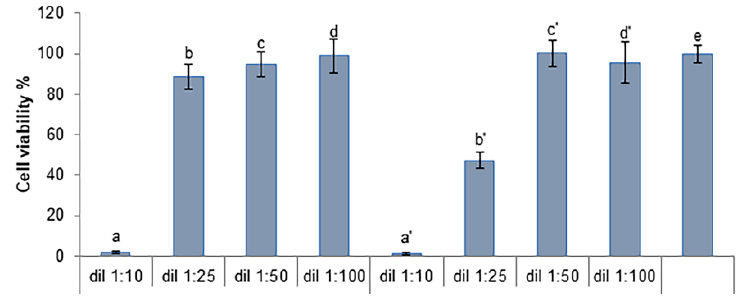
Figure 5. Cell viability, expressed as percentage of metabolically active cells, after treatment with the samples diluted in CM (1:10, 1:25, 1:50 and 1:100 ( v / v )). a–d: [Cu 2 (BPXD)](CF 3 SO 3 ) 4 ; a’–d’: Cu(CF 3 SO 3 ) 2 ; CM (e) was used as reference (mean value ± s.d.; n= 6). ANOVA one-way; Sheffé test ( p < 0.05): a vs. b–d, e; b vs. b’; a’ vs. b’–d’, e; b’ vs. c’, d’, e.